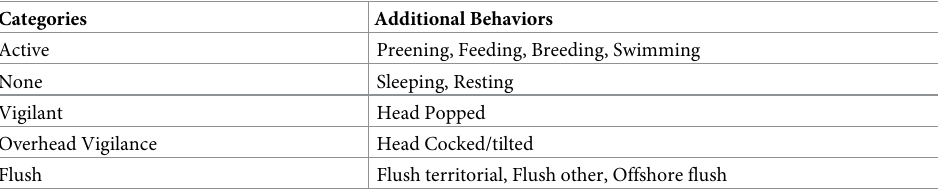
Table 1. Categories and types of behaviors for focal behavior surveys on breeding duck pairs conducted in Sheri- dan County, North Dakota during the spring of